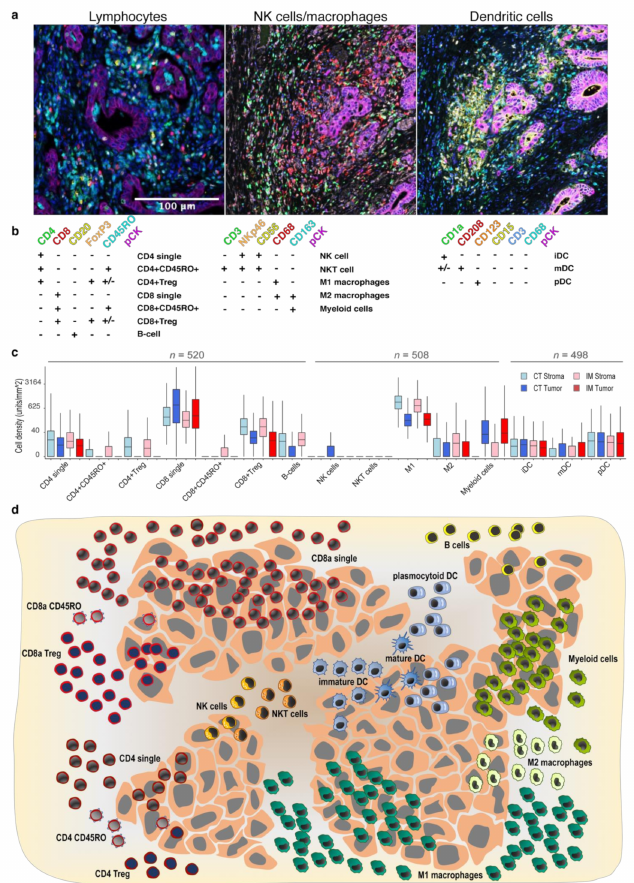
Figure 1. Characterization of immune cell subsets in the tumor and stroma compartments at the invasive margin and core of the tumor of primary CRC. ( a ) Representative images of the multiplex staining with three immune panels; ( b ) scheme of the immune marker combinations used to define the subgroups of immune cells; ( c ) immune cell densities in Tumor and Stroma compartments in Central Tumor (CT) and Invasive Margin (IM) (boxes show median values and interquartile range, and numbers represent cell counts per mm 2 , cube root transformed); and ( d ) illustration of the mean immune cell infiltration in tumor center in tumor and stromal